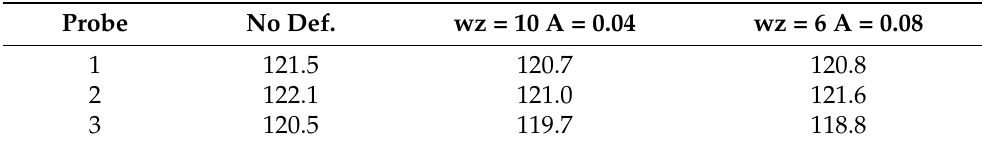
Table 4. Overall Sound Pressure Level results for the probes corresponding to the plate placement of d = 0.75 D j L = 4 D j